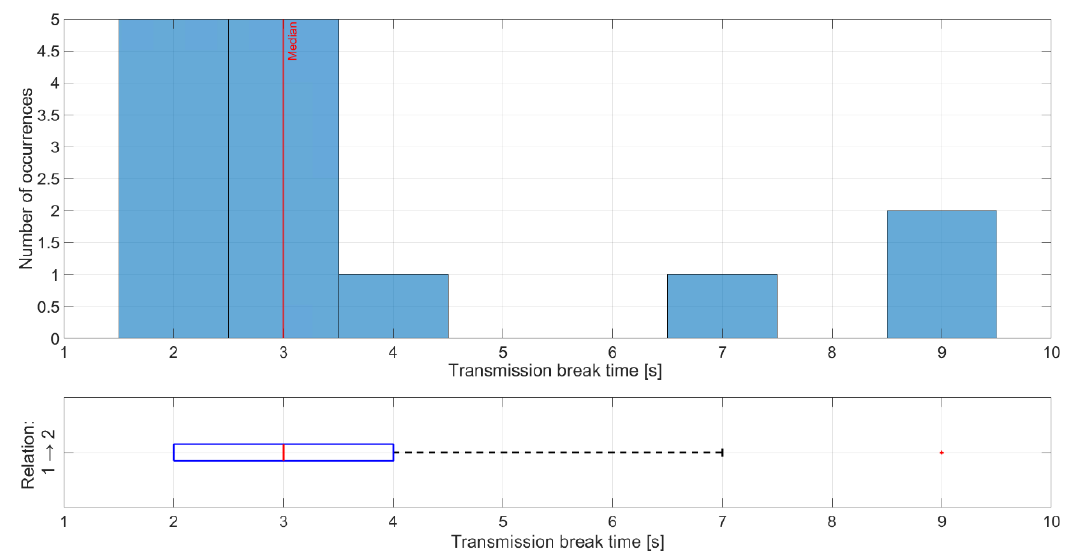
Figure 17. Distribution of transmission time breaks for relationship 1 and 2.